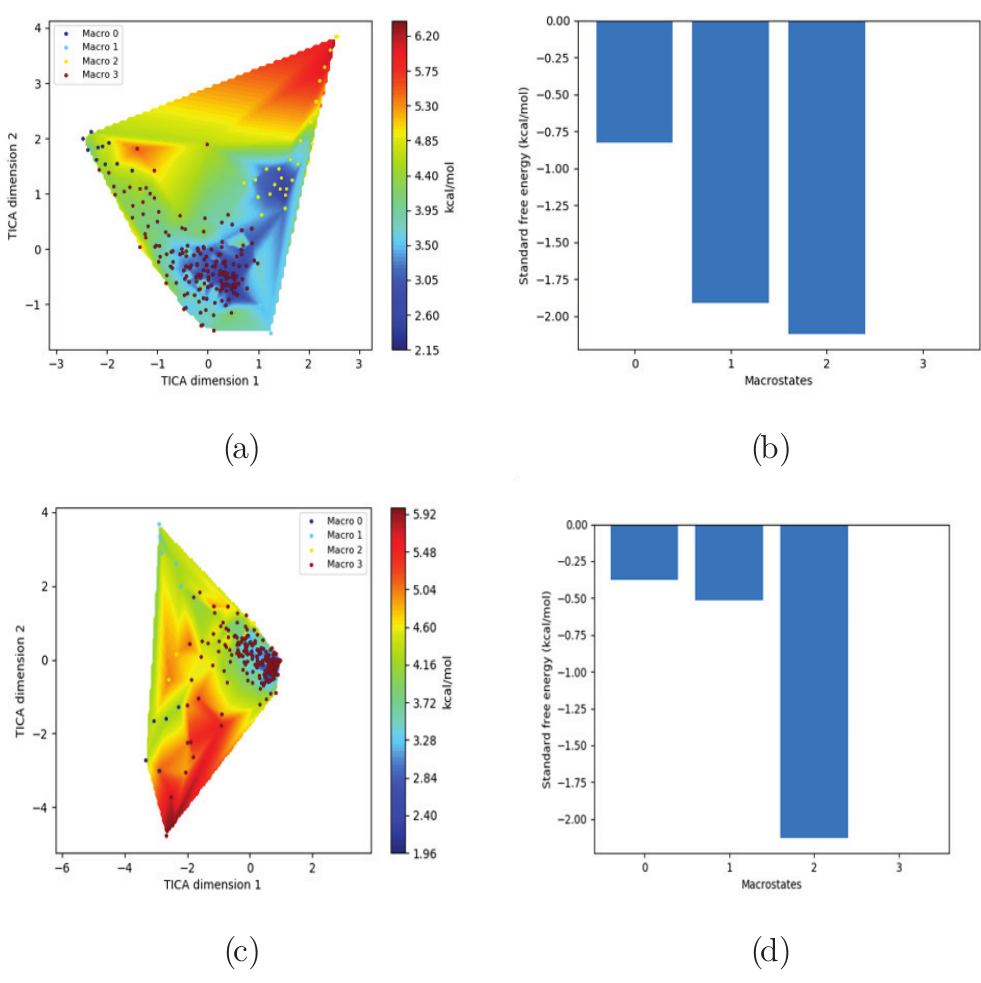
Figure 4 Free energy surface projected on the first two TICA dimensions and the corresponding stan- dard free energy of meta-stable states of Villin for the MSM models. (A) Free energy surface of MSM constructed with all contacts, (B) Standard free energy of meta-stable states plotted in (A), (C) Free energy surface of MSM constructed with selected with selected contacts, (D) Standard free energy of meta-stable states plotted in (C). Full-size DOI: